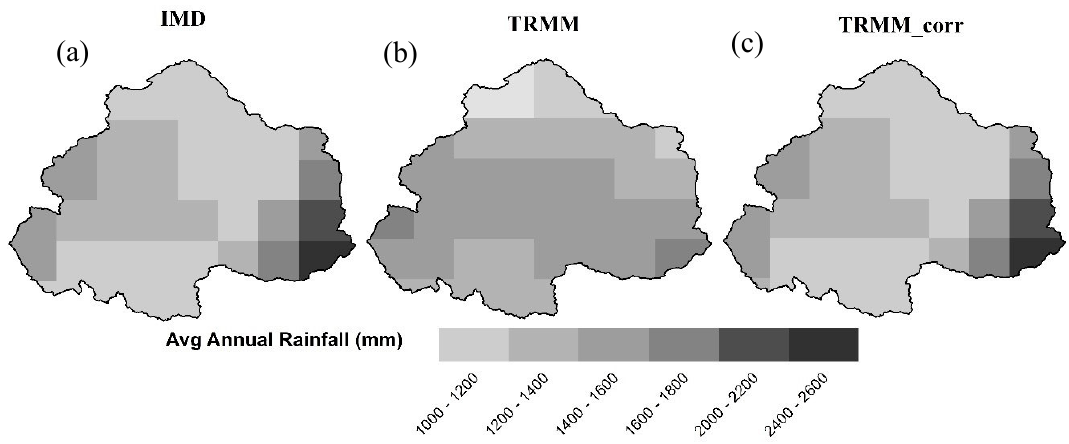
Figure 8. Spatial plot of average annual precipitation obtained from ( a ) IMD, ( b ) TRMM and ( c ) bias corrected TRMM.